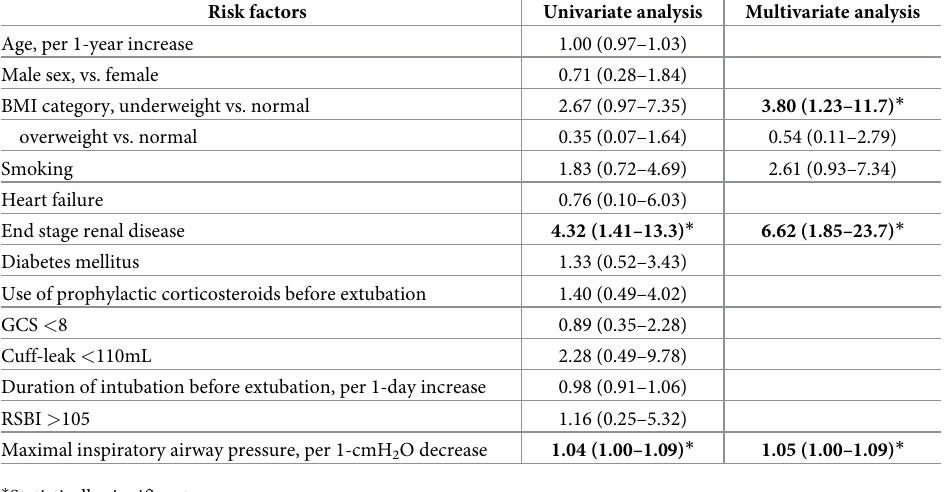
Table 3. Univariate and multivariate logistic regression of risk factors associated with extubation